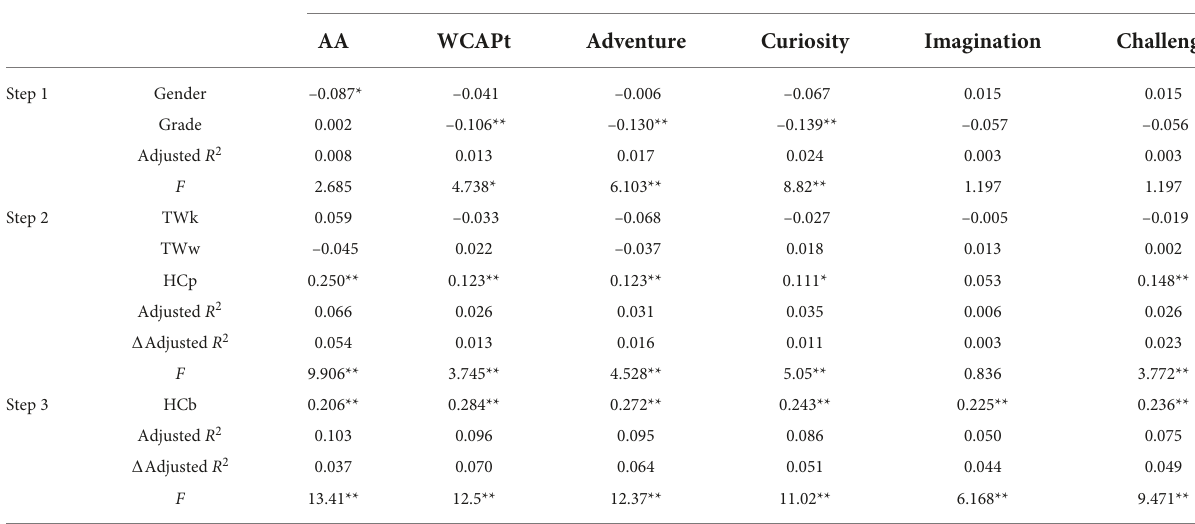
TABLE 4 Regression analyses of homework creative behavior on academic achievement and general